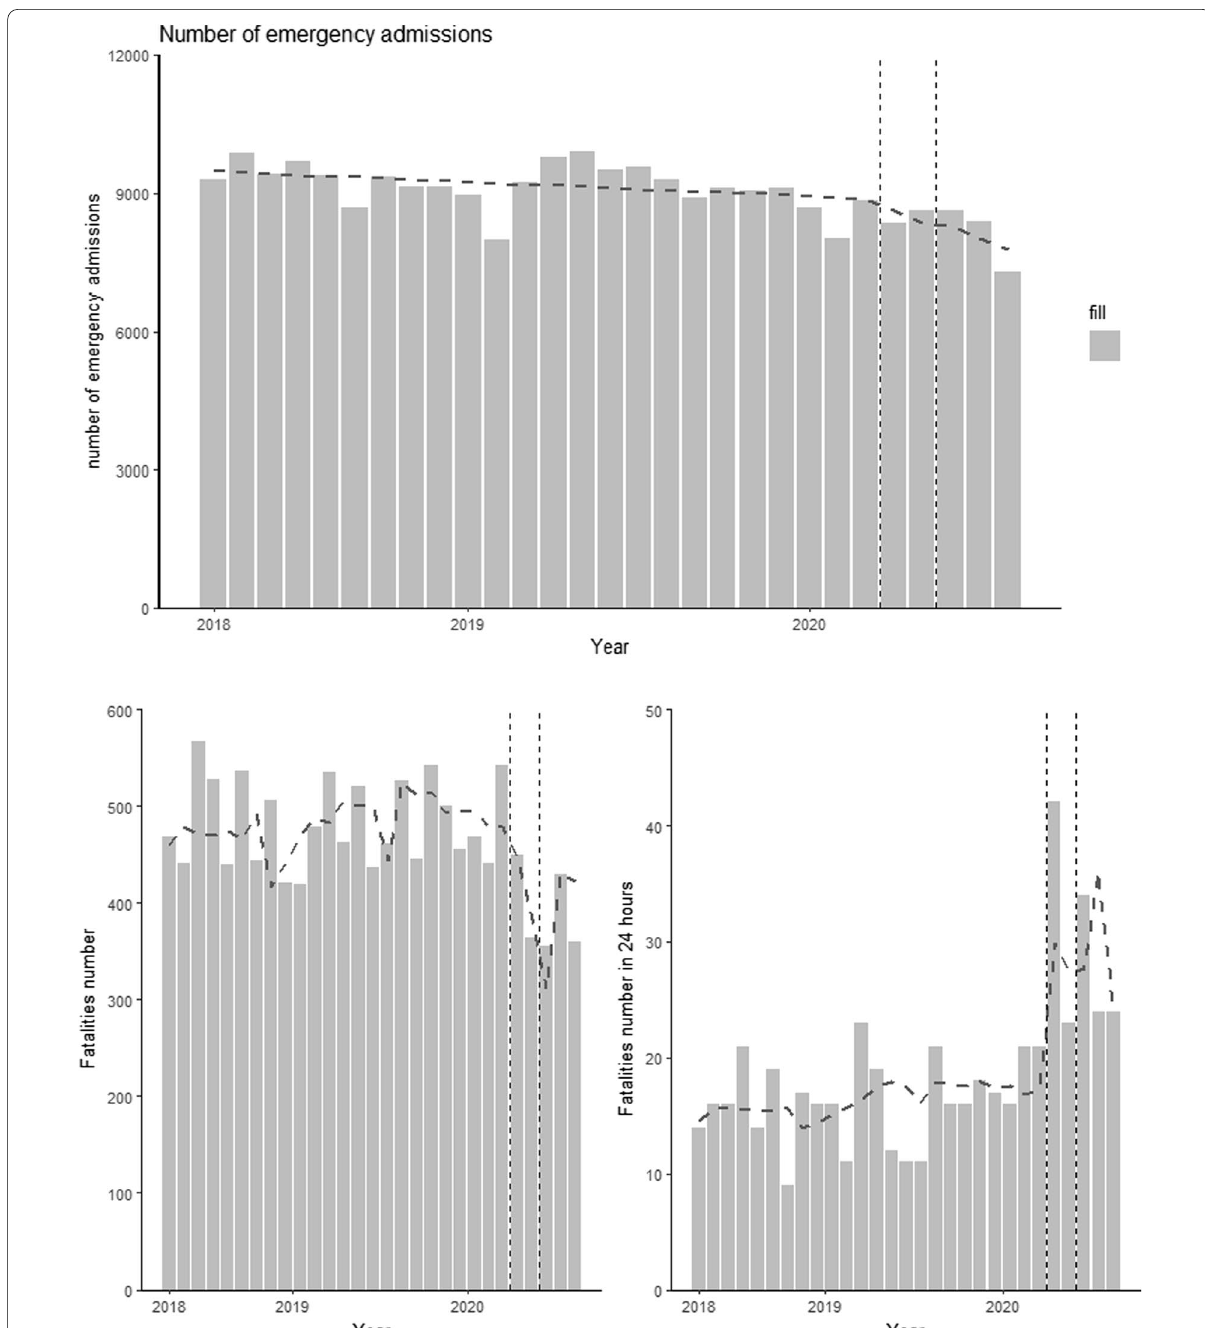
Fig. 2 Interrupted time series analysis of emergency stroke admissions in the COVID-19